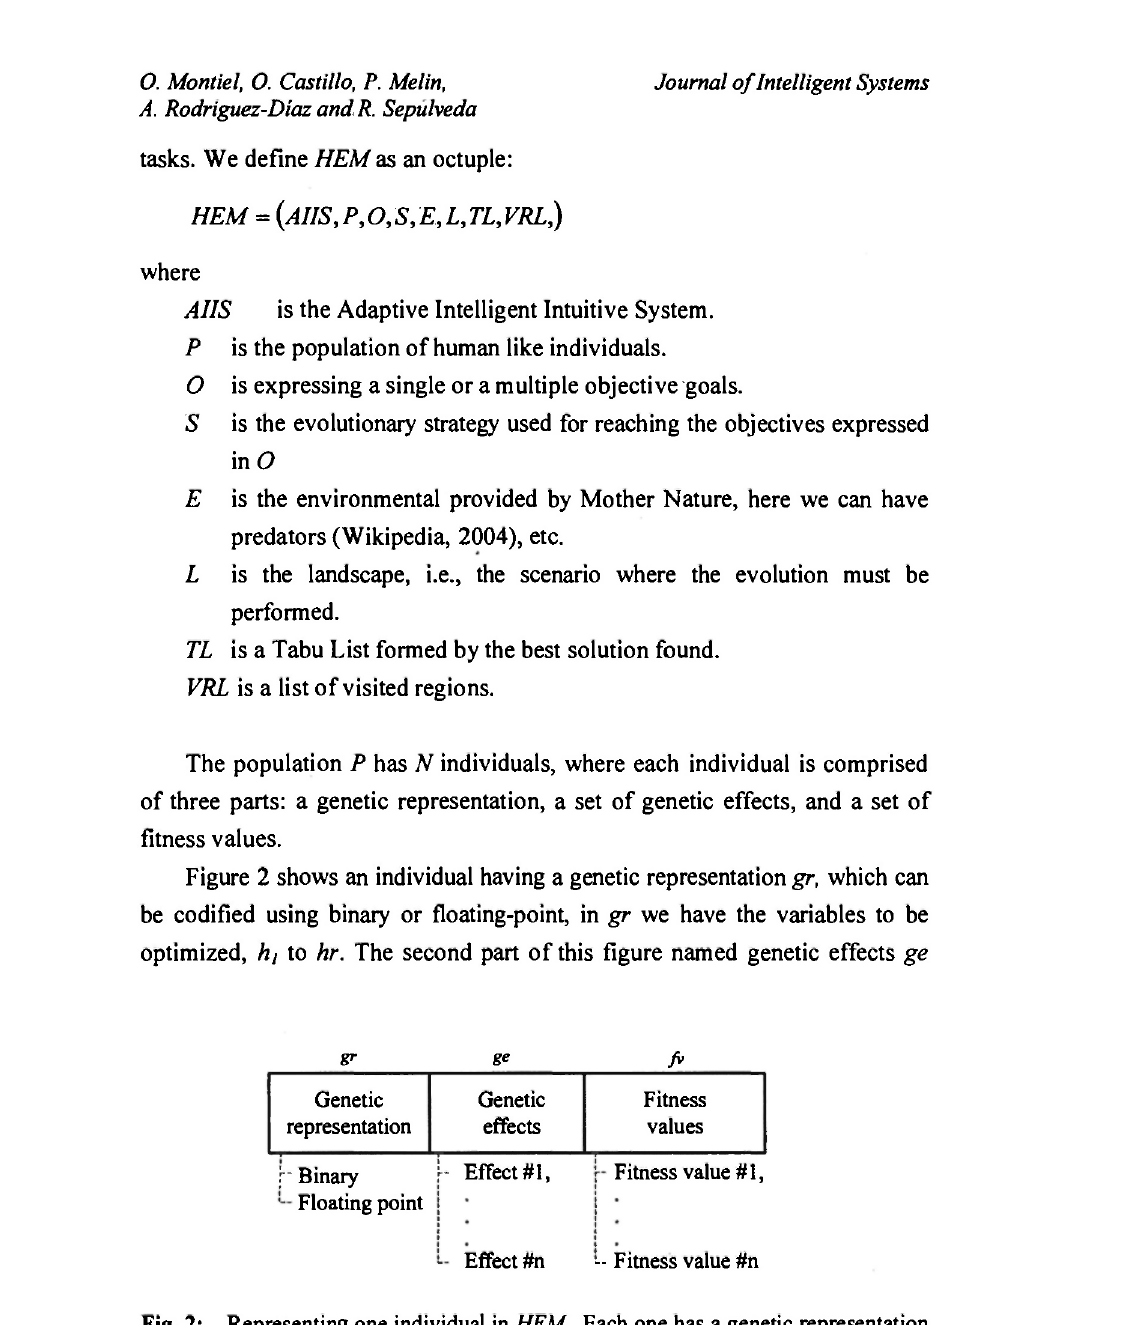
Fig. 2: Representing one individual in HEM. Each one has a genetic representation (gr); a set of control parameters called genetic effects (ge); the evaluation of the individual can performed using one ore several objective functions, this is depending of problem's nature, this evaluation is expressed as a set of fitness values